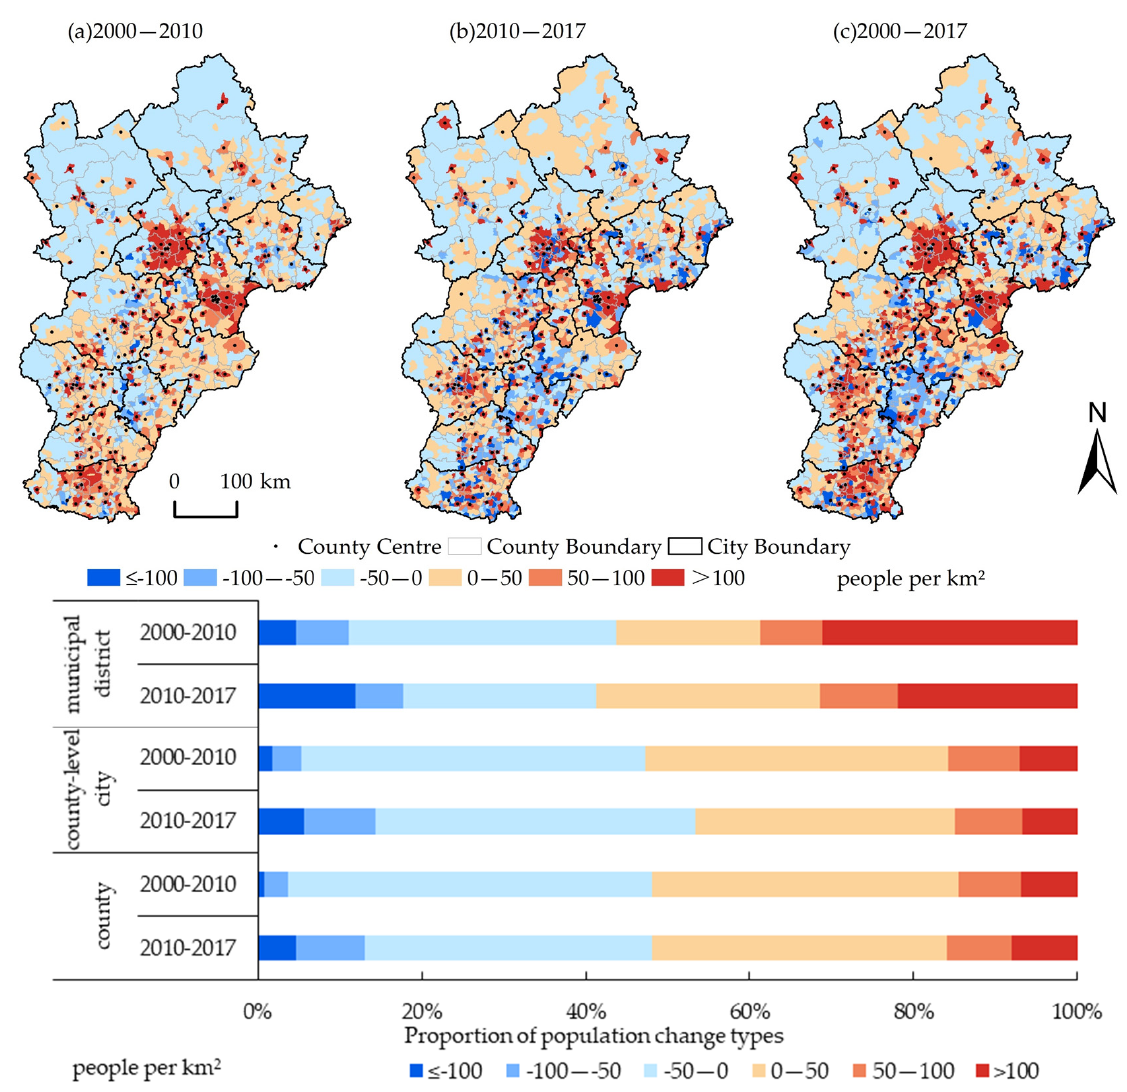
Figure 5. Spatial distribution of population density changes in the Beijing–Tianjin–Hebei region from 2000 to 2017 and the proportion of various types.